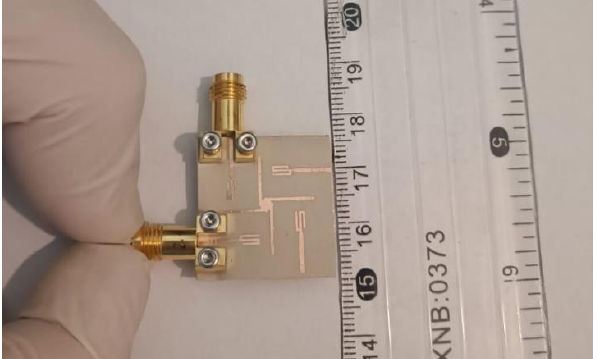
Figure 6. Fabricated Prototype.